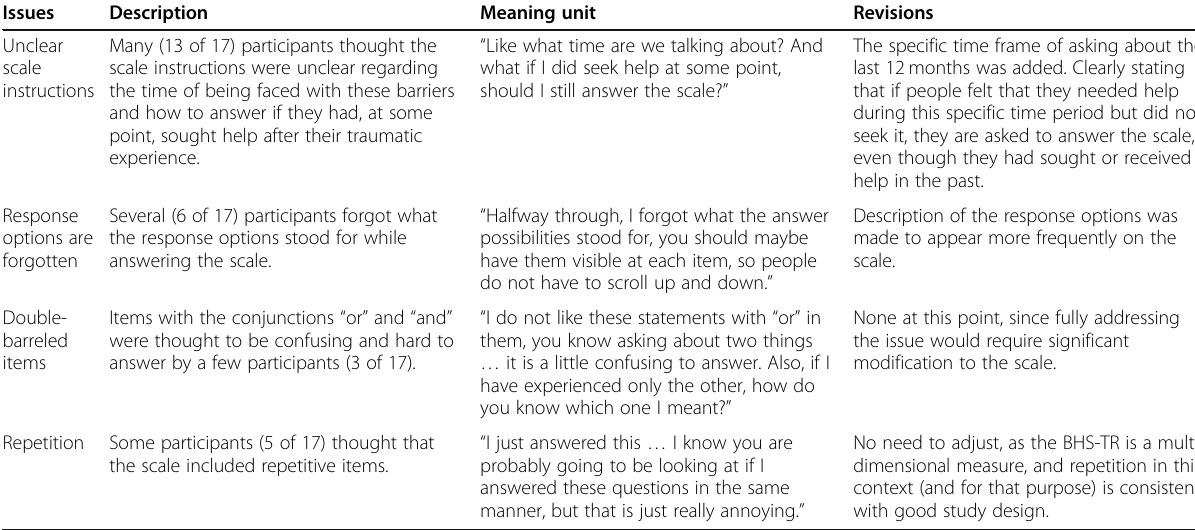
Table 4 Examples of general design issues